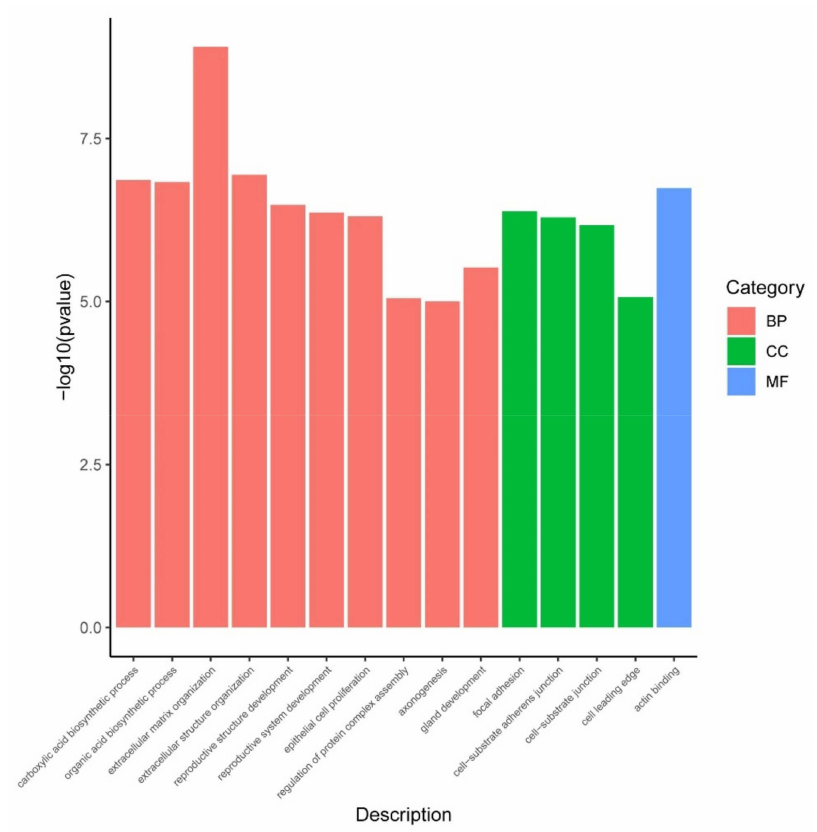
Figure 10. GO enrichment analysis of DEGs after BUP